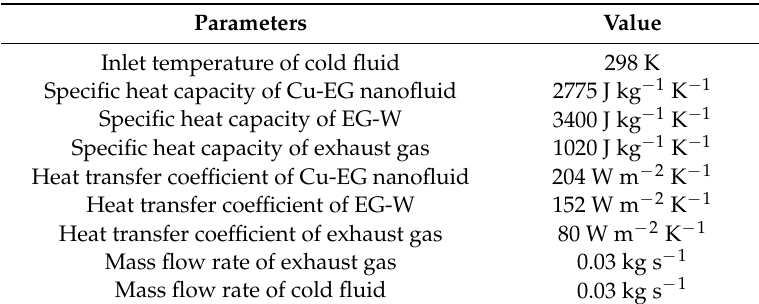
Table 2. Basic computational parameters of